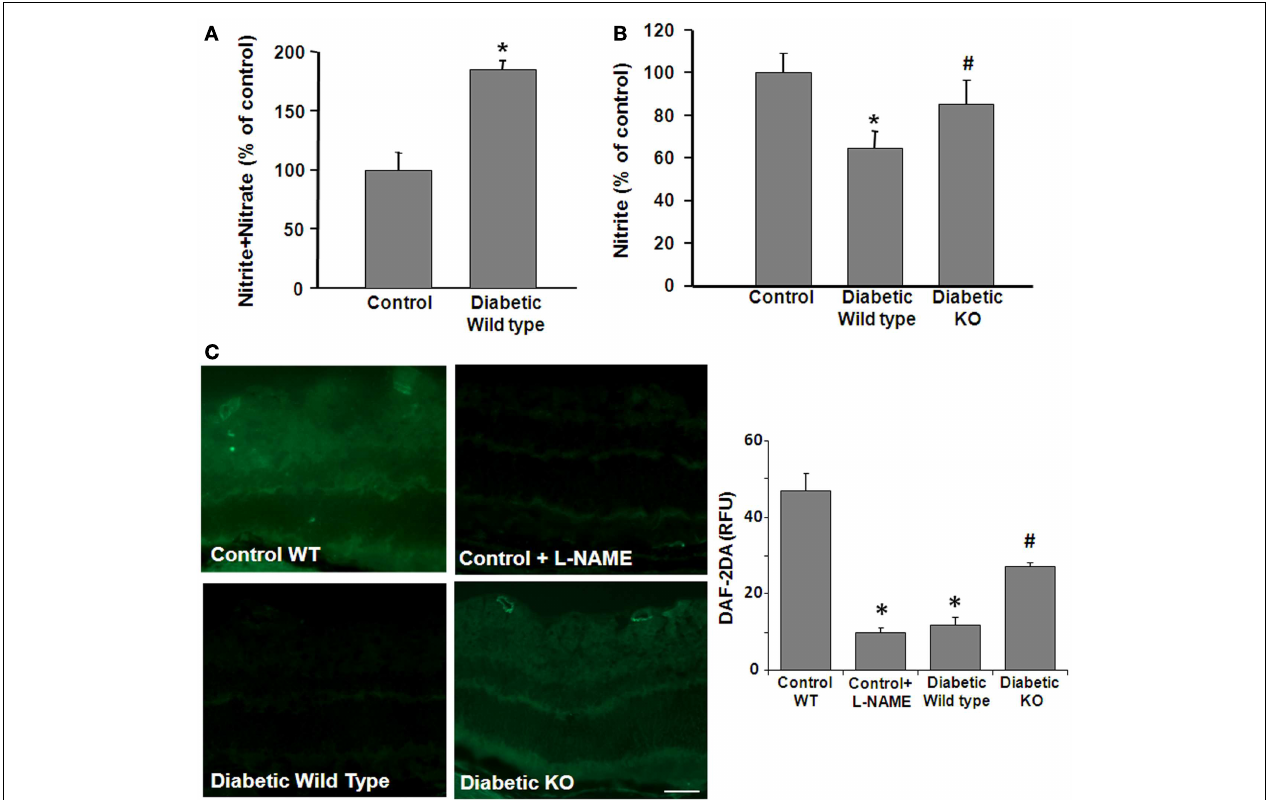
of nitrite levels.The decrease in nitrite levels was blocked in the diabetic KO mice (* p < 0.05, n = 4–6). (C) NO formation in situ was determined by reaction of DAF-2-DA.The DAF-2-DA fluorescent product was significantly diminished in the wildtype diabetic retina as compared with the non-diabetic control.This effect was significantly blunted in the diabetic KO retinas. Pretreatment of the retinal sections with L-NAME (1mM) markedly reduced formation of the DAF-2-DA product (* p < 0.05 vs. control, # p < 0.05 vs. diabetic, n = 4–6, scale bar = 50 µ